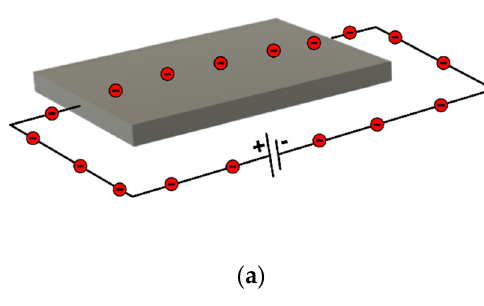
Figure 2. ( a ) MEMS magnetometer—( b ) Hall effect.